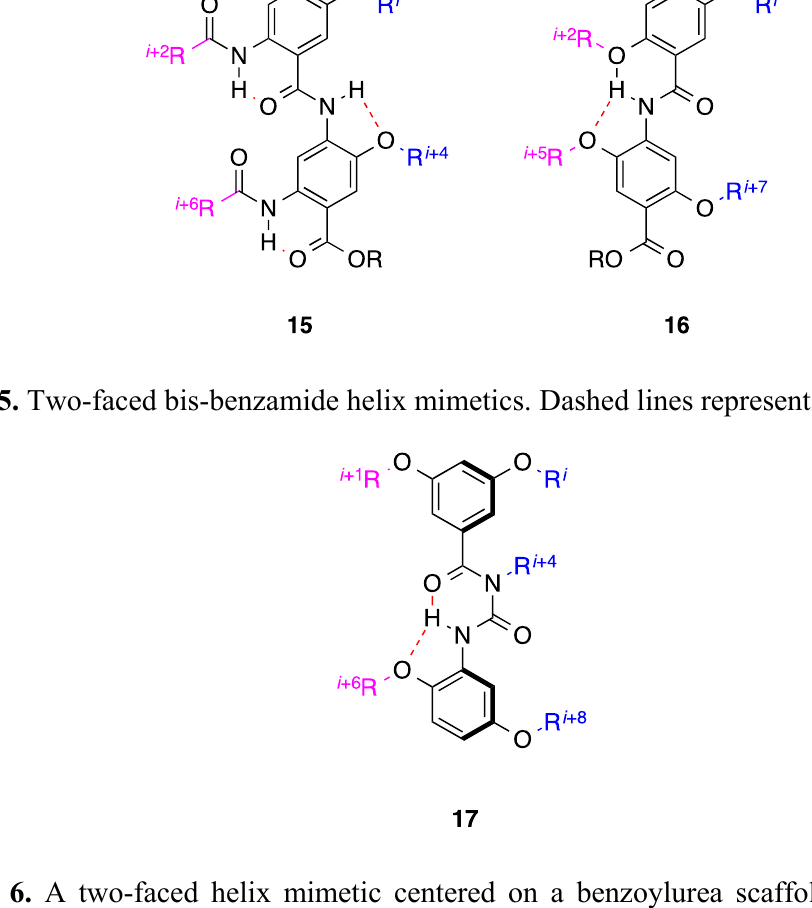
Figure 6. A two-faced helix mimetic centered on a benzoylurea scaffold. Dashed lines represent a bifurcated hydrogen